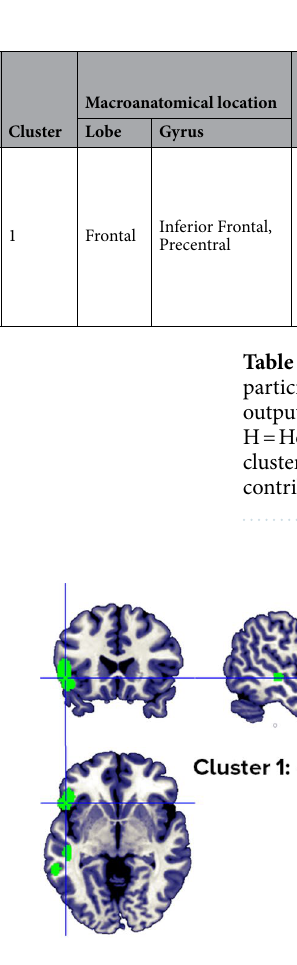
Figure 8. Clusters activated by the abstract > concrete words—visual stimuli—contrast. The crosses are centered in the areas correspond to stereotactic coordinates reported in Table 8. The images are presented in neurological